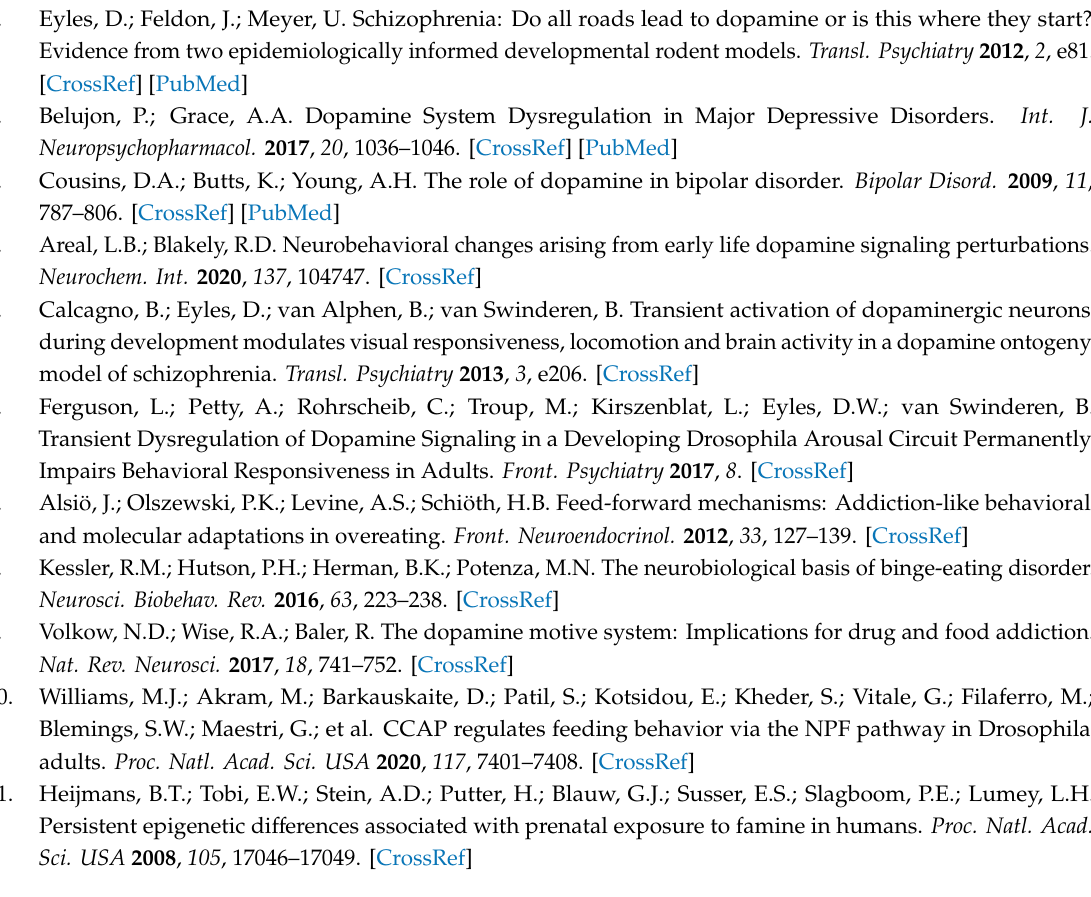
Table S1: Least-squares multiple linear regression model results. The table show estimates of the overall e ff ect for the number of sips parameter, of treatment (0 = control; 1 = levodopa), sex (0 = male; 1 = female), and age (1, 3 or 5 days old) factors, for the F0 and F1 generations, Table S2: Levodopa increases the number of activity bouts, but di ff erentially modulates its duration. Treatment was delivered in the food for 2 days to 6 h, 3 days or 5 days post-eclosion (p.e.) flies before the behavioral testing at 7-days old, as described in Figure 1A. All groups exhibited higher number of activity bouts, although the di ff erence for flies treated 3 days p.e. did not reach statistical significance. The average activity bout duration was significantly higher for female groups only (Student t test; alpha = 0.05). Sample sizes are the same as shown in Figure 1, Table S3: O ff spring of levodopa-treated flies at 6 h, 3 days or 5 days post-eclosion (p.e.) have altered feeding behavior depeding on sex and age of parental treatment. Female o ff spring of flies treated during early adulthood (6h and 3d p.e.) exhibited significantly higher number of activity bouts, while the activity bout duration was increased for 3d-p.e. F 1 females and 6h-p.e. F 1 males (Student t test; alpha = 0.05). Sample sizes are the same as shown in Figure